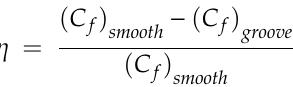
Table 3. Friction coe ffi cient and drag reduction rate of di ff erent riblets and grooves with di ff erent Mach number. Flat Triangular Plate Concave